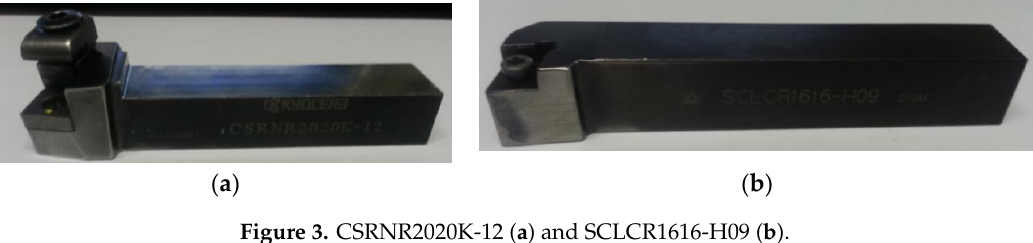
Table 1. The geometry of used tools.